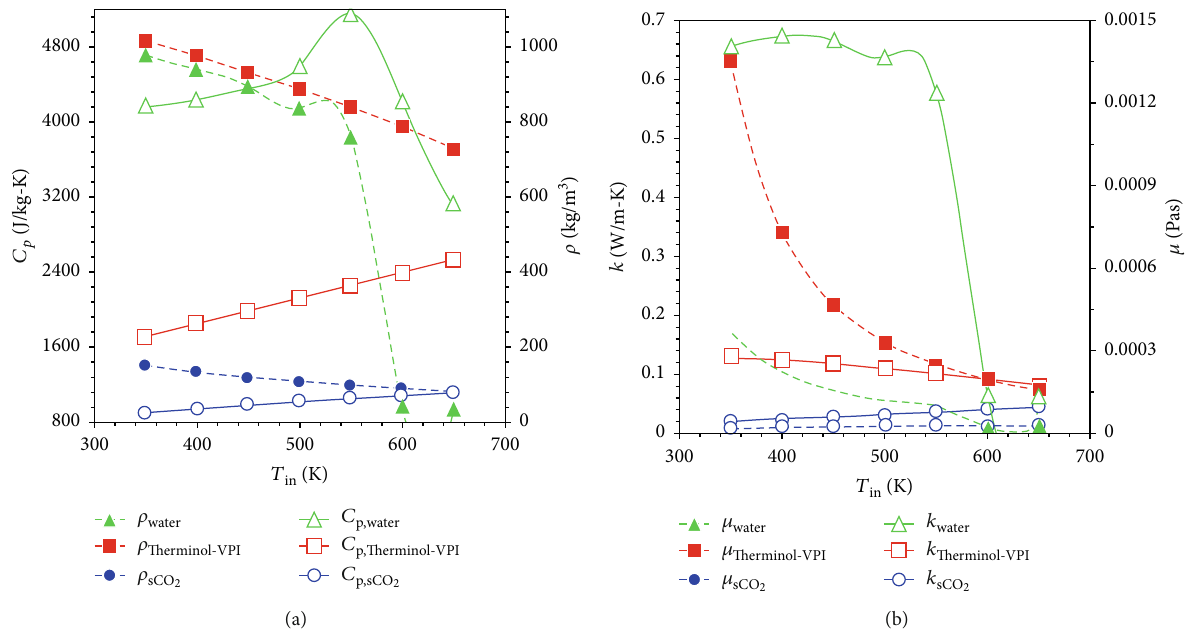
Figure 6: Comparison of properties (a) density and speci fi c heat capacity and (b) thermal conductivity and